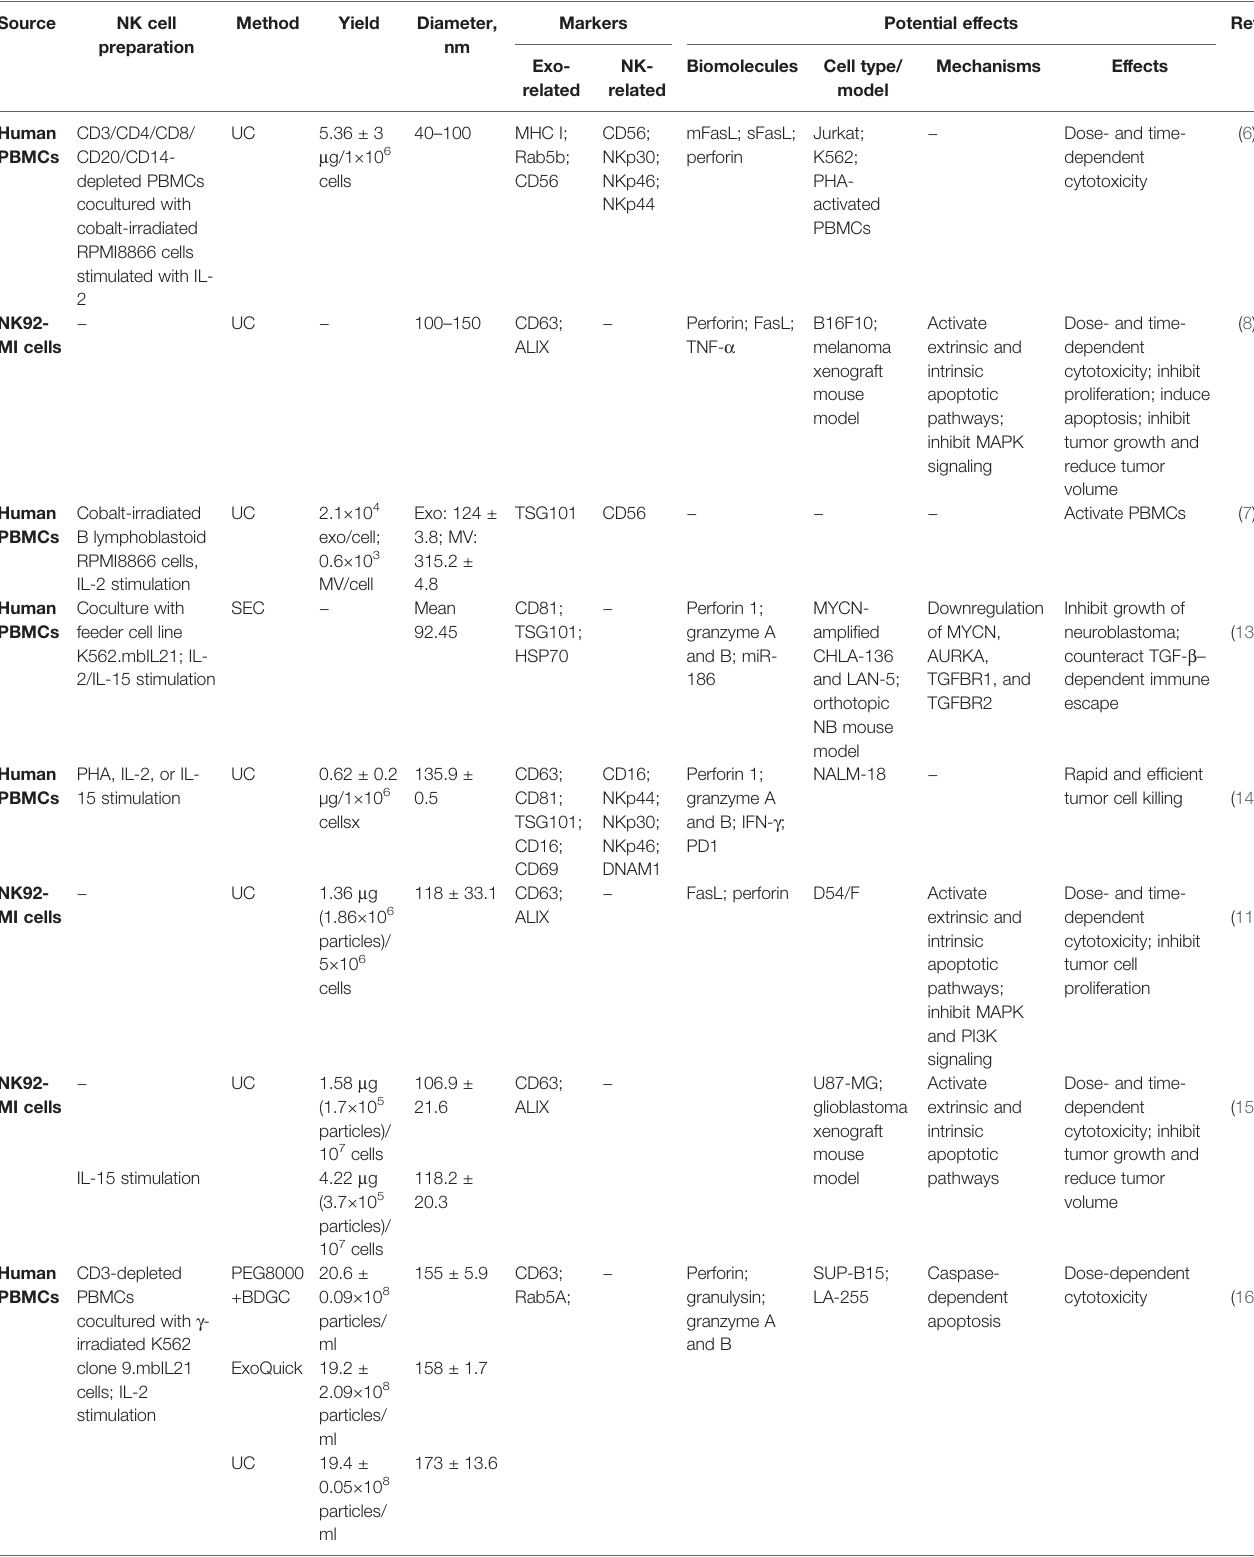
TABLE 1 | Isolation, characterization, and biological effects of